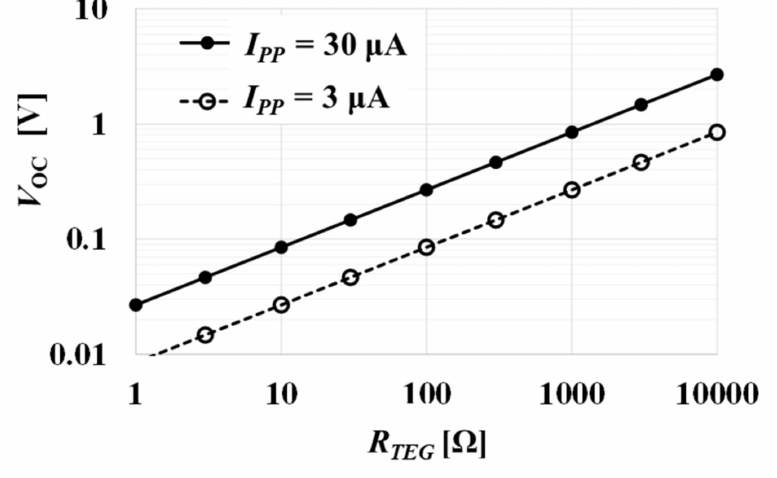
Figure 6. V OC vs. R TEG with different I PP , η = 0.5, V PP = 3 V.